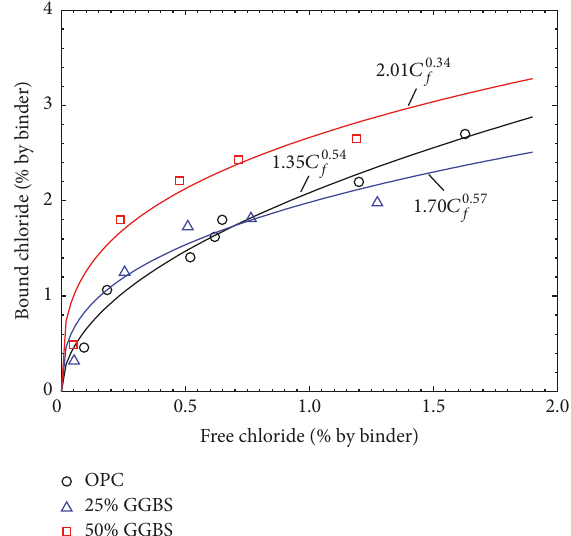
Figure 1: Regression plots of Freundlich isotherm with experimen- tal data.